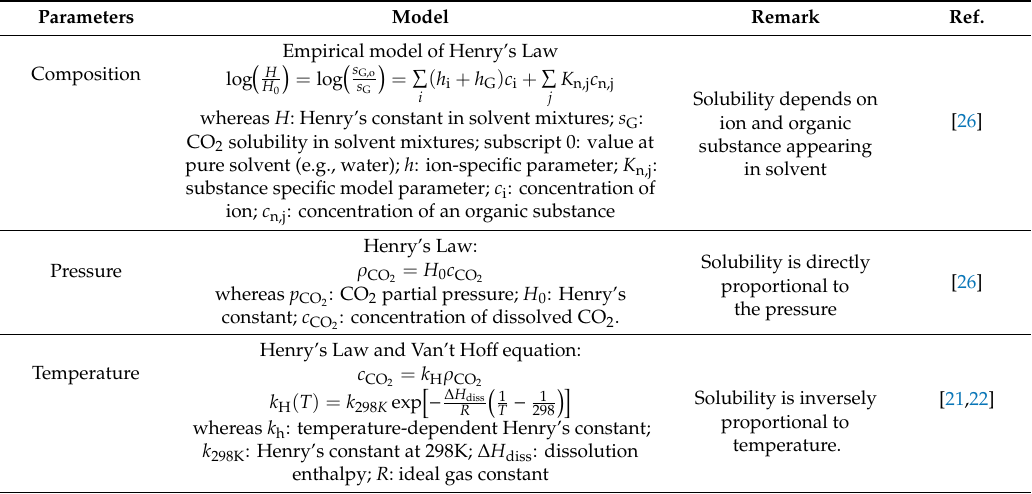
Table 2. Mathematical model of e ff ects of pressure, temperature, and composition on gas solubility. Parameters